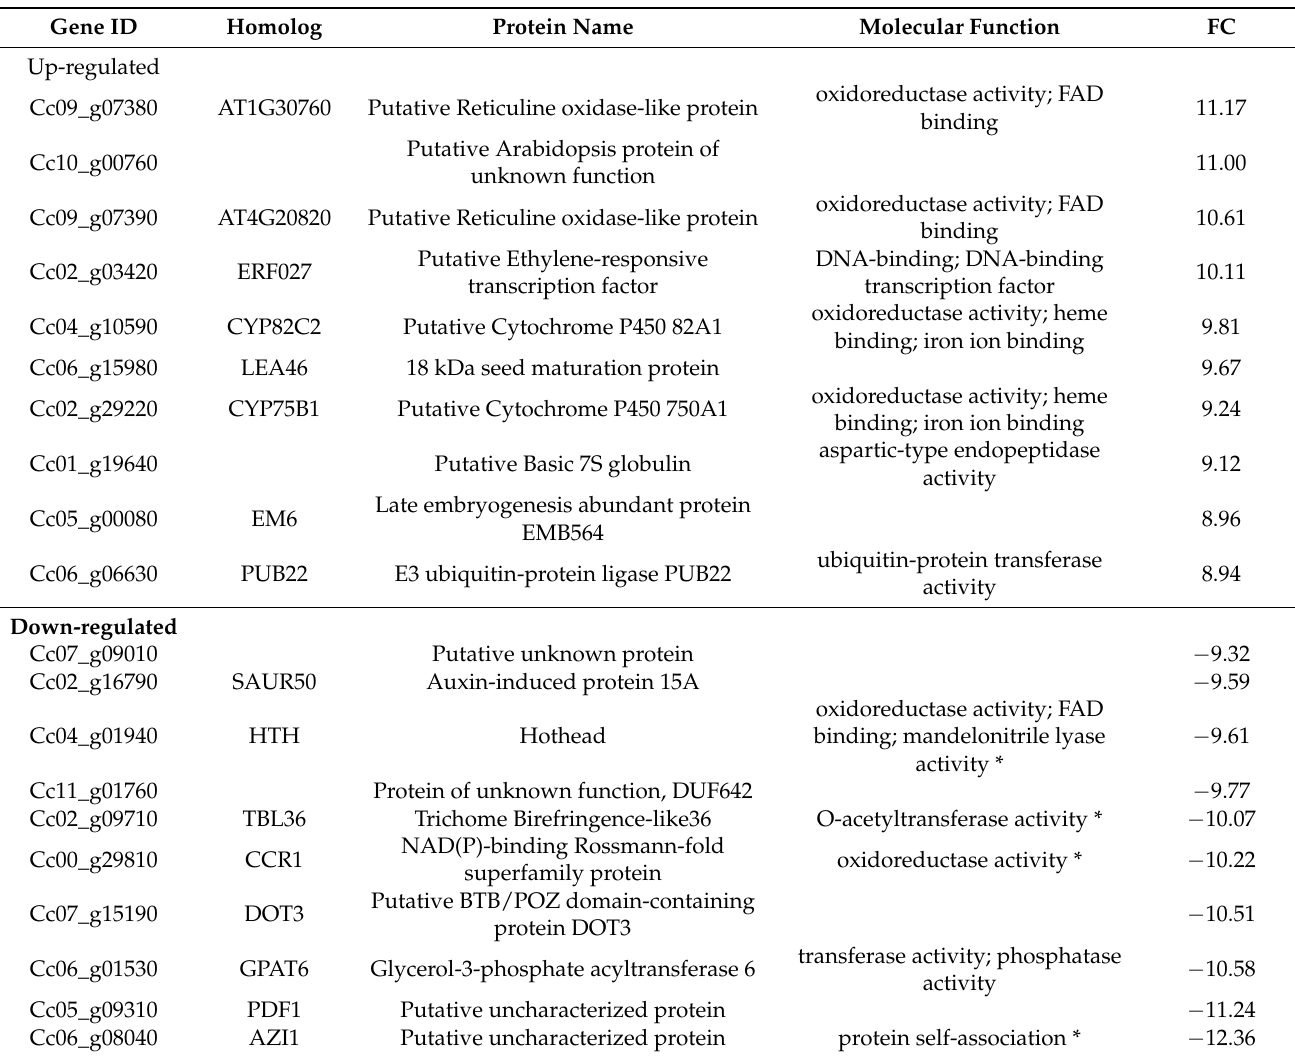
Table 1. Top 10 up- and down-regulated differentially expressed genes (DEGs) under moderate water deficit (MWD) relative to well-watered (WW) C. canephora cv. Conilon Clone CL153 (CL153) plants. Molecular functions were retrieved from UniprotKB database (* functions exclusive to A. thaliana homologs). Genes are descending fold changes (FC).